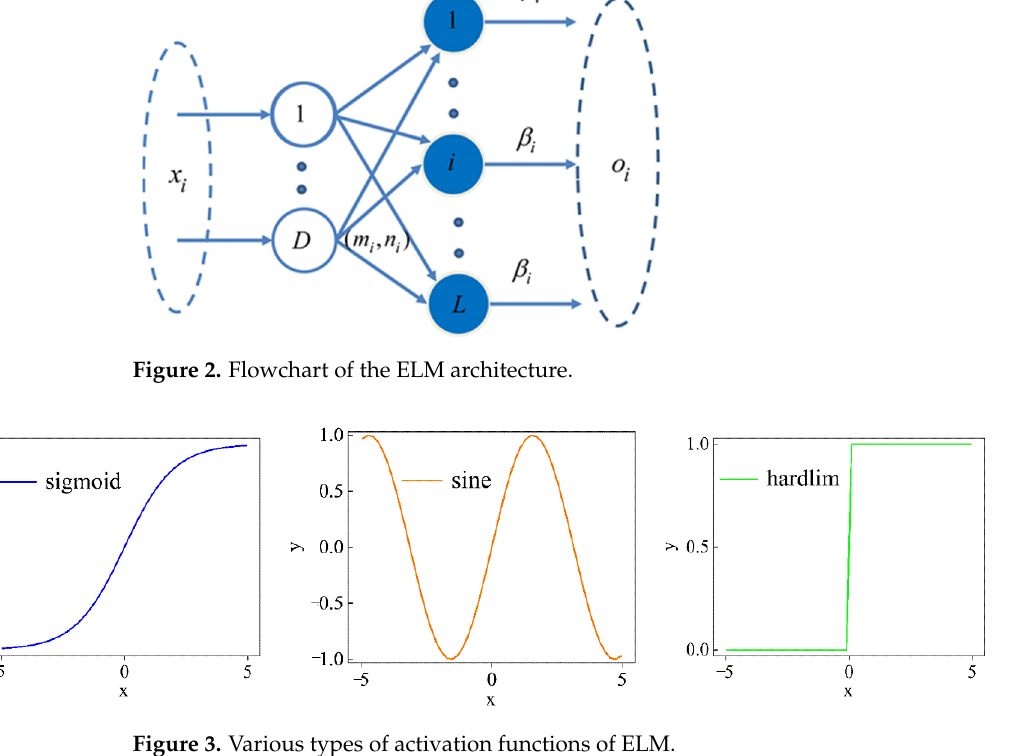
Figure 2. Flowchart of the ELM architecture.